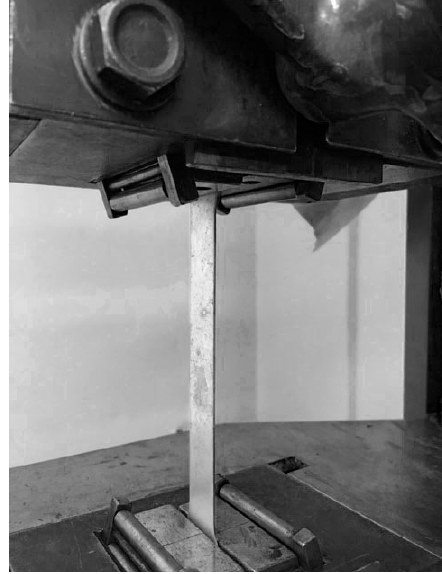
Figure 3. The location of the sample during the experiment.